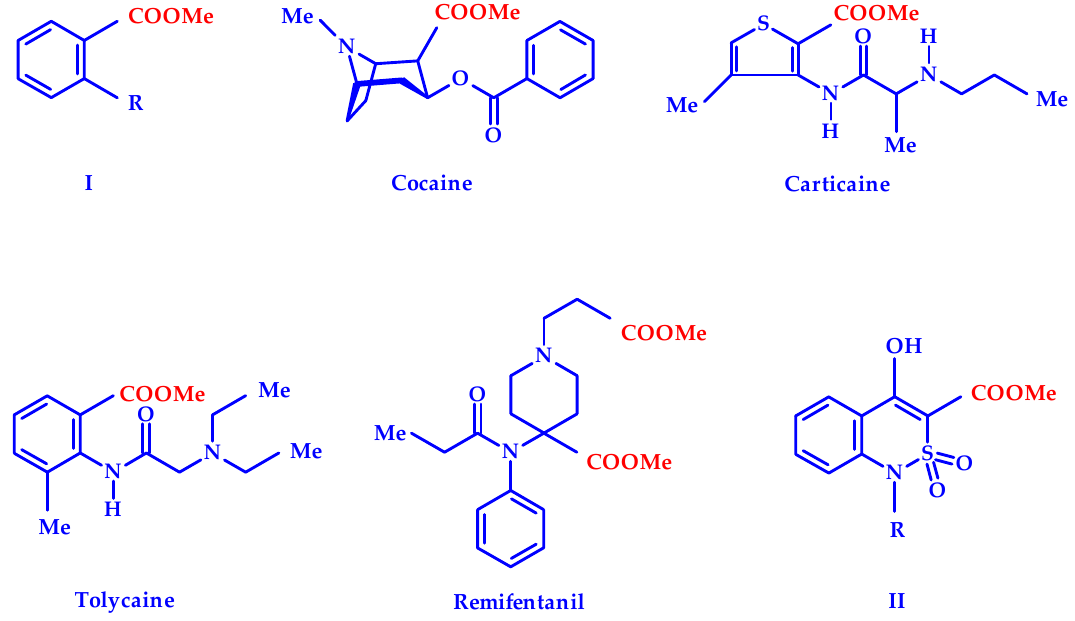
Figure 1. Natural and synthetic methyl esters with marked analgesic properties [1–11].